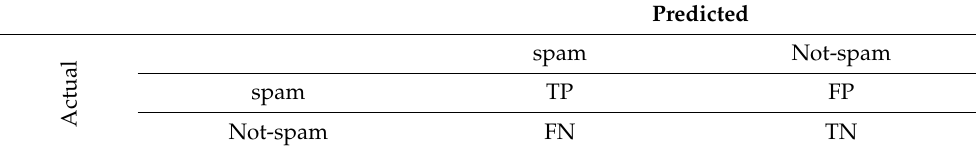
Table 4. Confusion